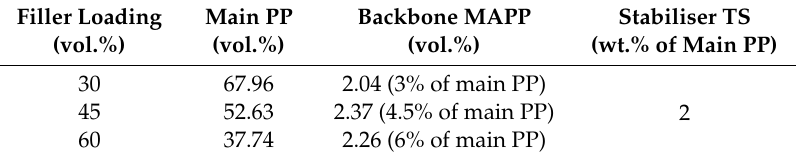
Table 1. Composition of the binder system used for different filler loading levels.